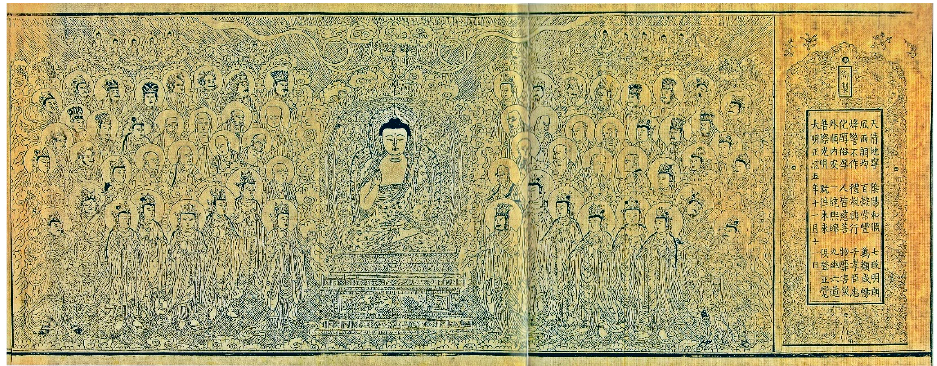
Figure 9. Madhyama Agama Sutra from the Yongle Northern Canon, 5th year of Zhengtong (1440), 38.0 × 13.0 cm, Zhihuasi Temple, Beijing (Beijing Cultural Exchange Museum 2007, pp. 110–11).